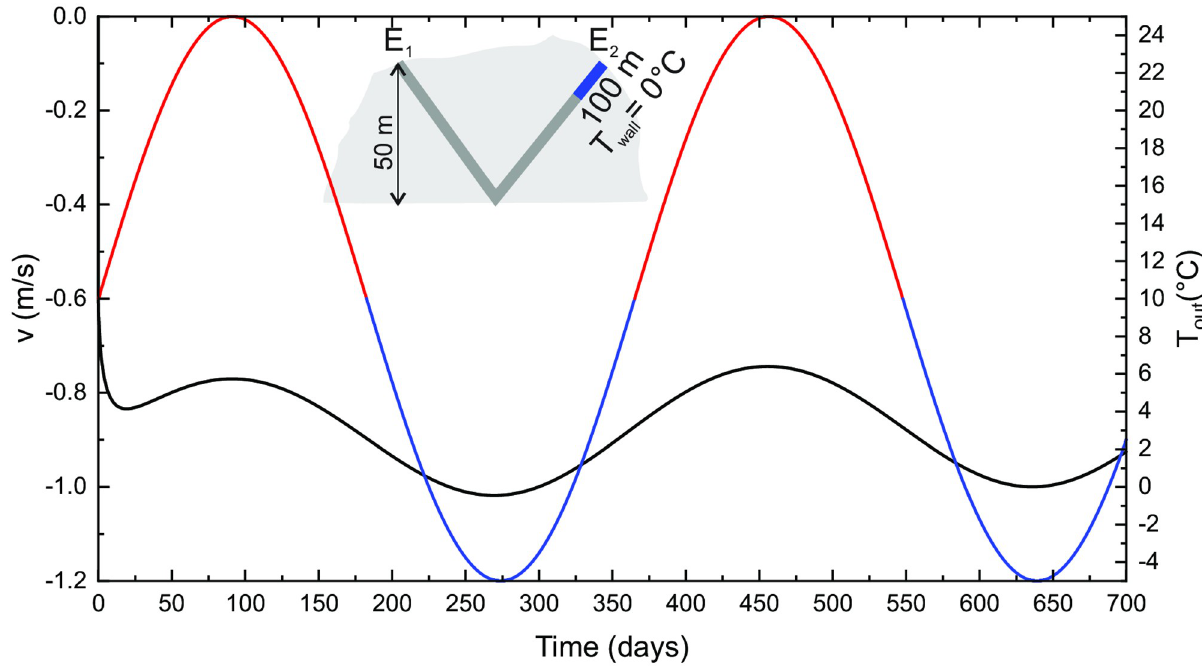
Fig 16. Airflow velocity and outside temperature for a V-shape system, where wall temperature along the section marked blue is set to